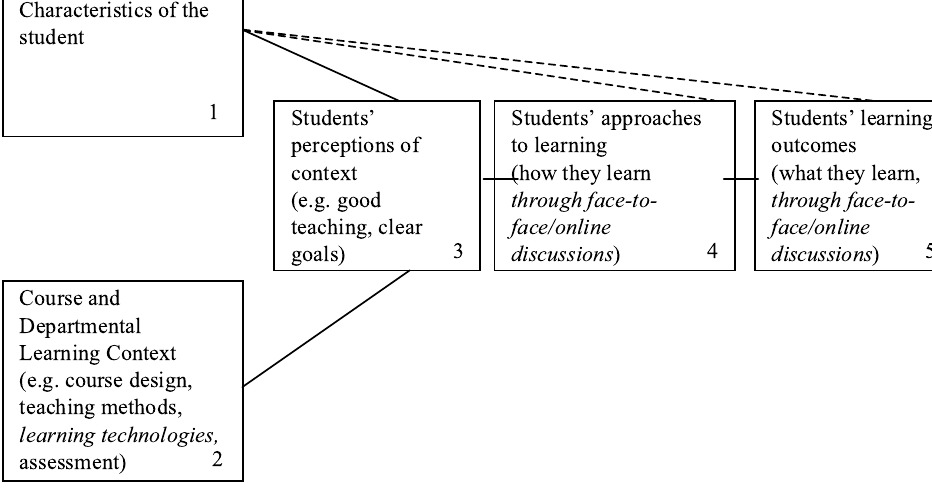
Figure 1. Figure 1. The 3P model of learning (after Trigwell & Prosser, 1997) Studies that underpin Figure 1 have shown that key aspects of the student learning